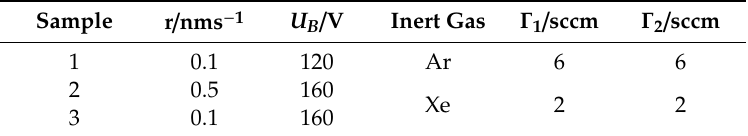
Table 3. Main deposition parameters for the plasma ion-assisted evaporation (PIAD) preparation of the titanium dioxide single-layer